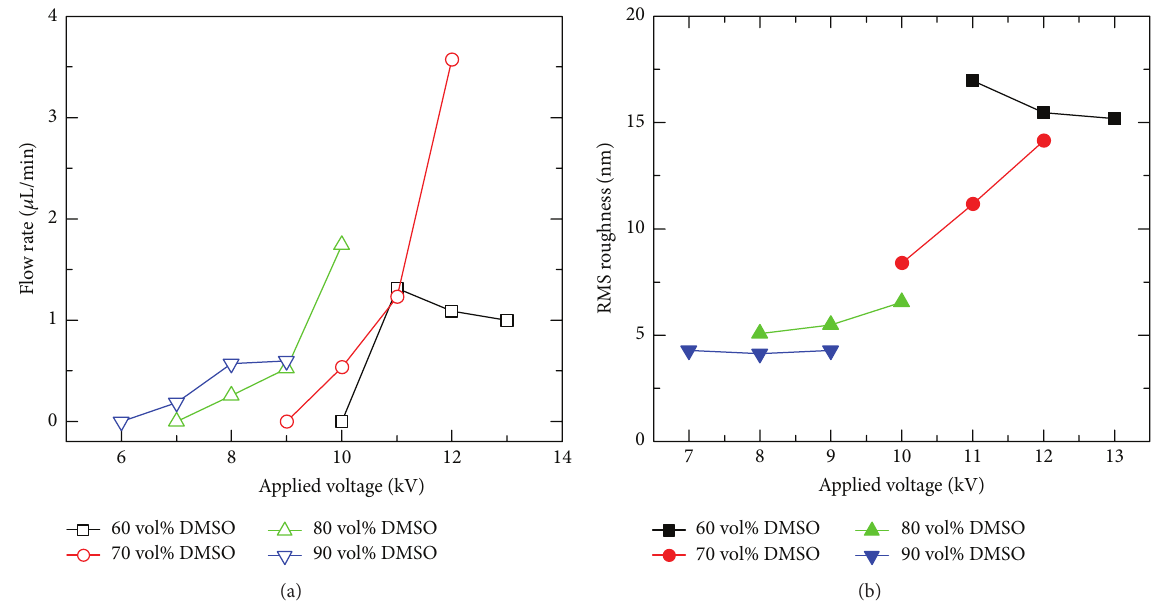
Figure 2: (a) Flow rate of the PEDOT:PSS inks at different voltage applied; (b) the RMS roughness of the resultant PEDOT:PSS thin films coated with the parameters shown in